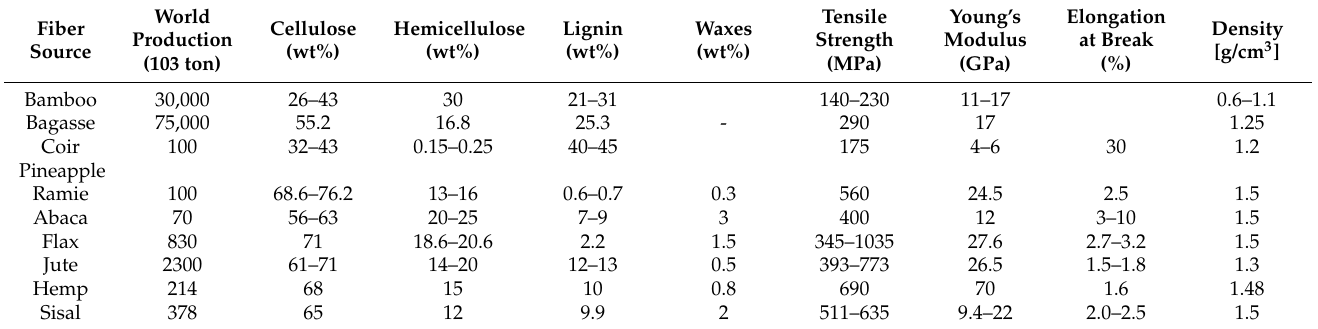
Table 1. Fiber source, world production, cellulose content, tensile strength, Young’s modulus, and density of various natural fibers [17] (reproduced with thanks from Elsevier, License Number: